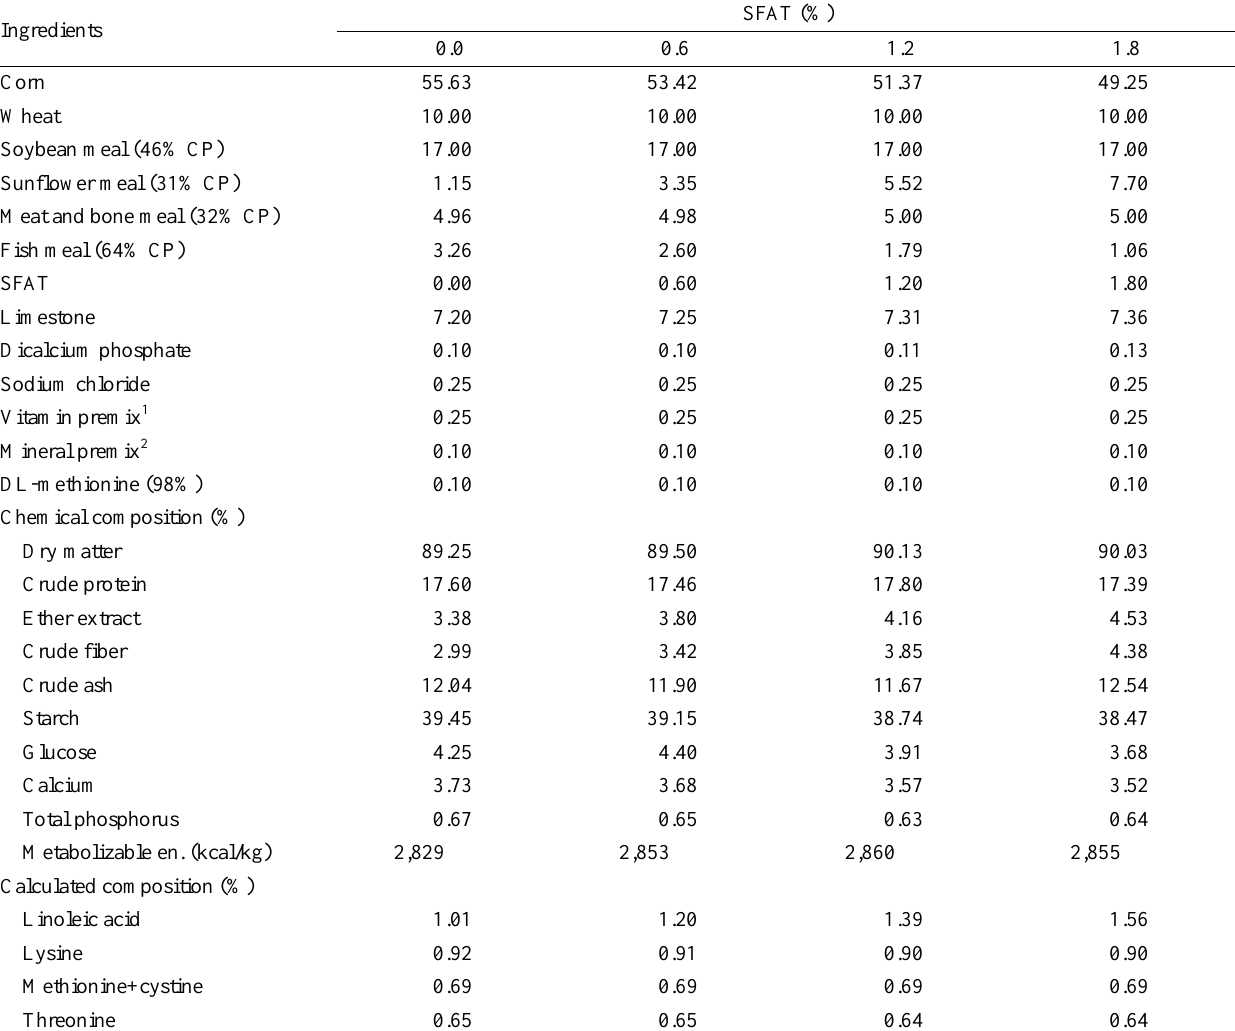
Table 2. Ingredients and chemical composition of the layer diets (as fed)